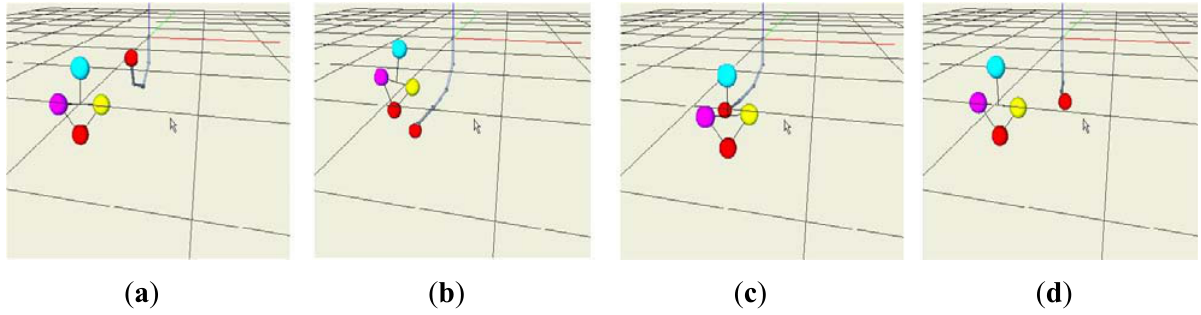
Figure 10. Measured positions. ( a ) Speed Increase; ( b ) Speed Decrease; ( c ) Left turn; and ( d ) Right turn.